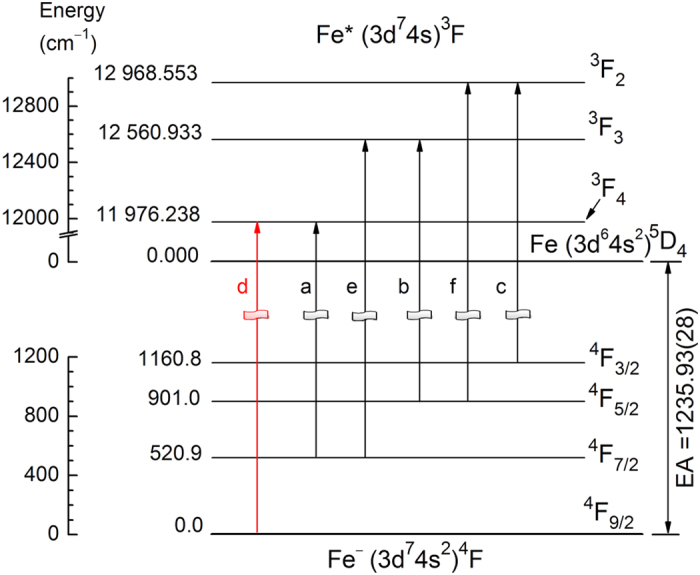
Energy levels of Fe and Fe− related to the present measurement.The ground state of Fe is 3d64s2 5D4. The ground state of Fe− is 3d74s2 4F9/2. The labels of each transition are the indexes of the observed peaks in Fig. 1. The transition d is used for the electron affinity measurement.